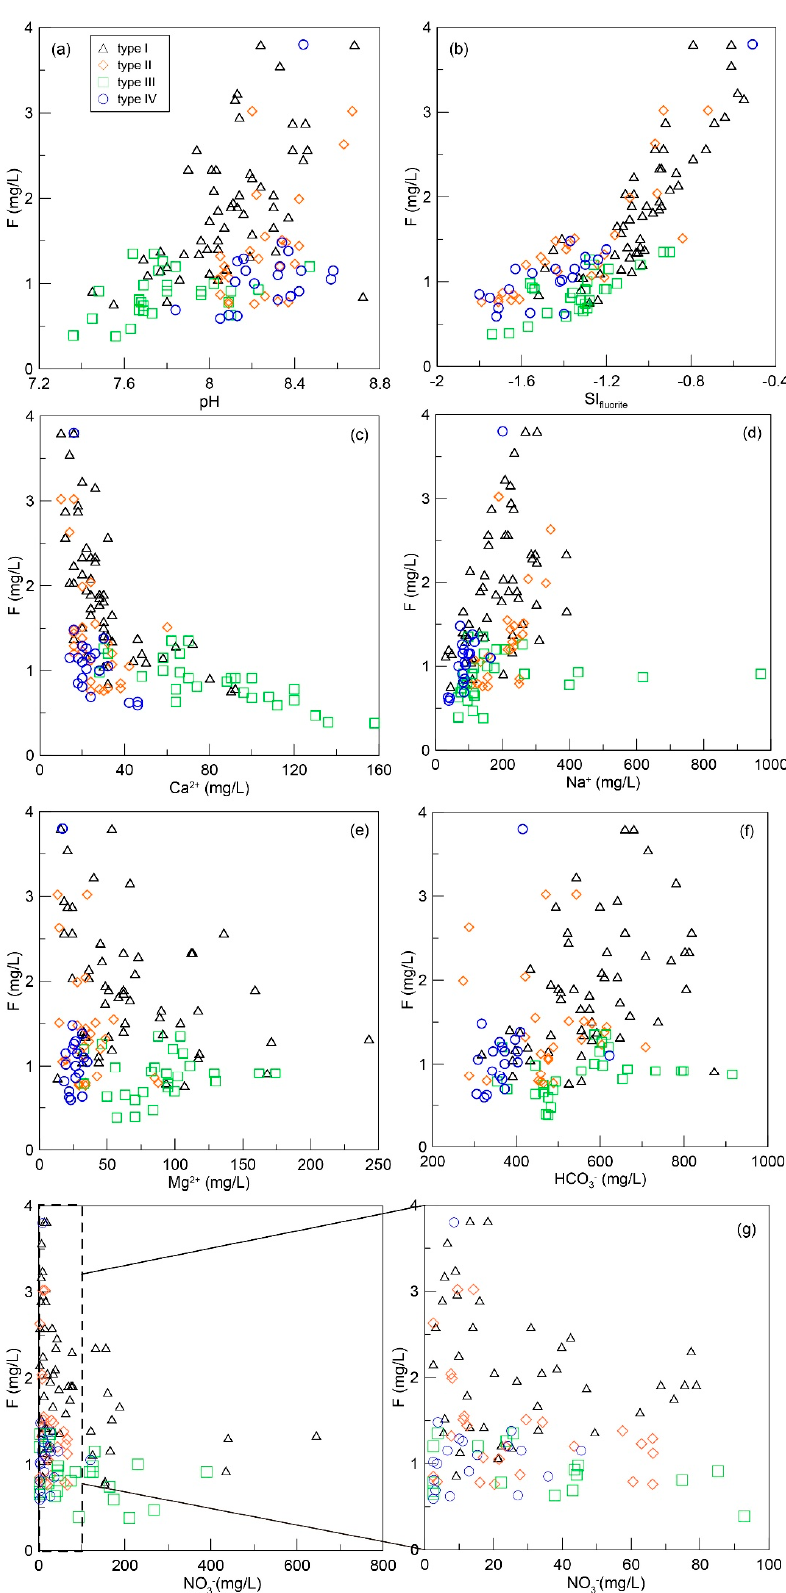
Figure 6. Scatter plots showing fluoride variation with hydrochemistry in groundwater. F − concentration versus ( a ) pH, ( b ) saturation index of fluorite, ( c ) Ca 2 + concentration, ( d ) Na + concentration, ( e ) Mg 2 + concentration, ( f ) HCO 3 − concentration, ( g ) NO 3 −